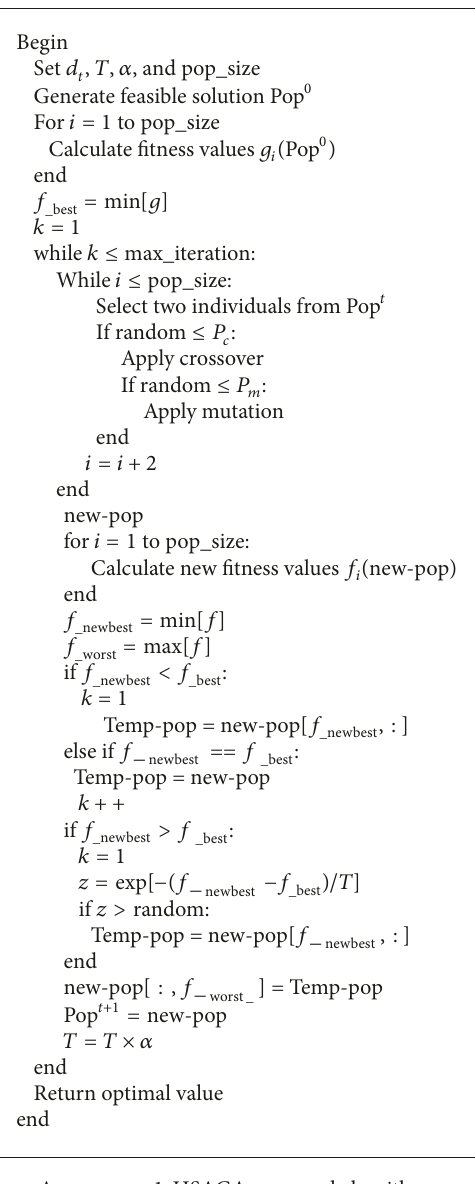
Algorithm 1: HSAGA proposed